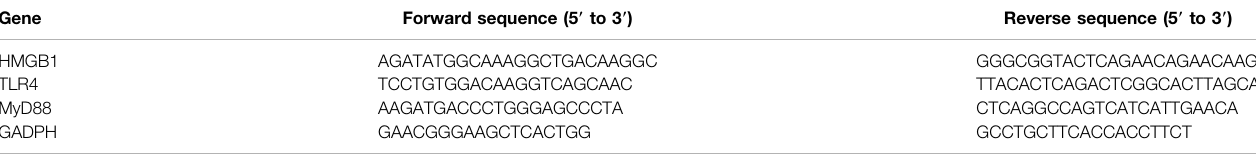
TABLE 1 | Primer sequences required for RT-qPCR. Gene